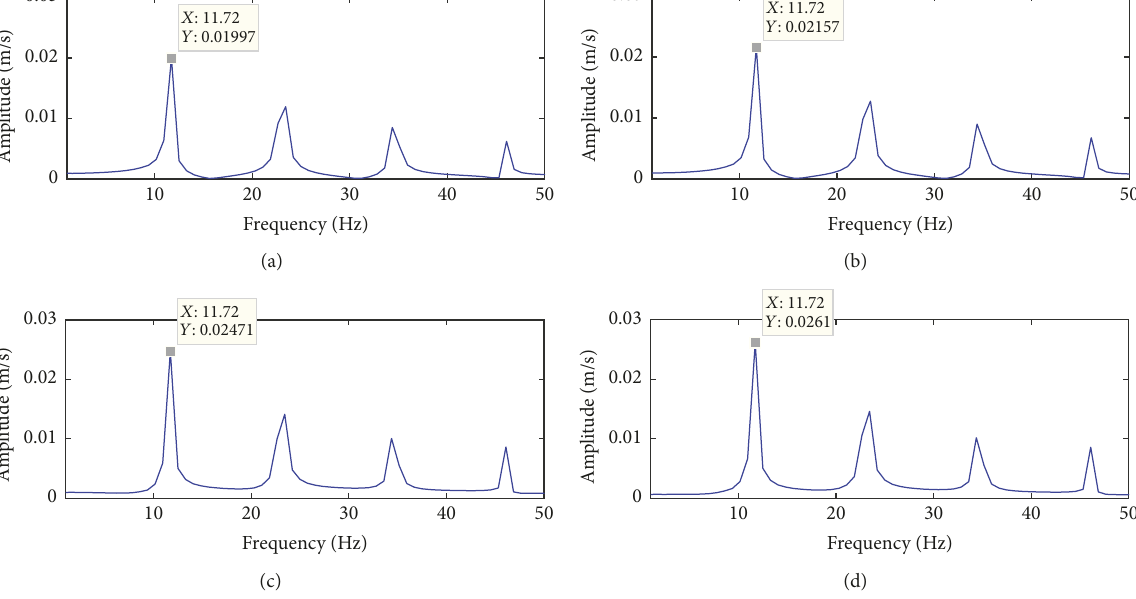
X : 11.72 Y : 0.01997